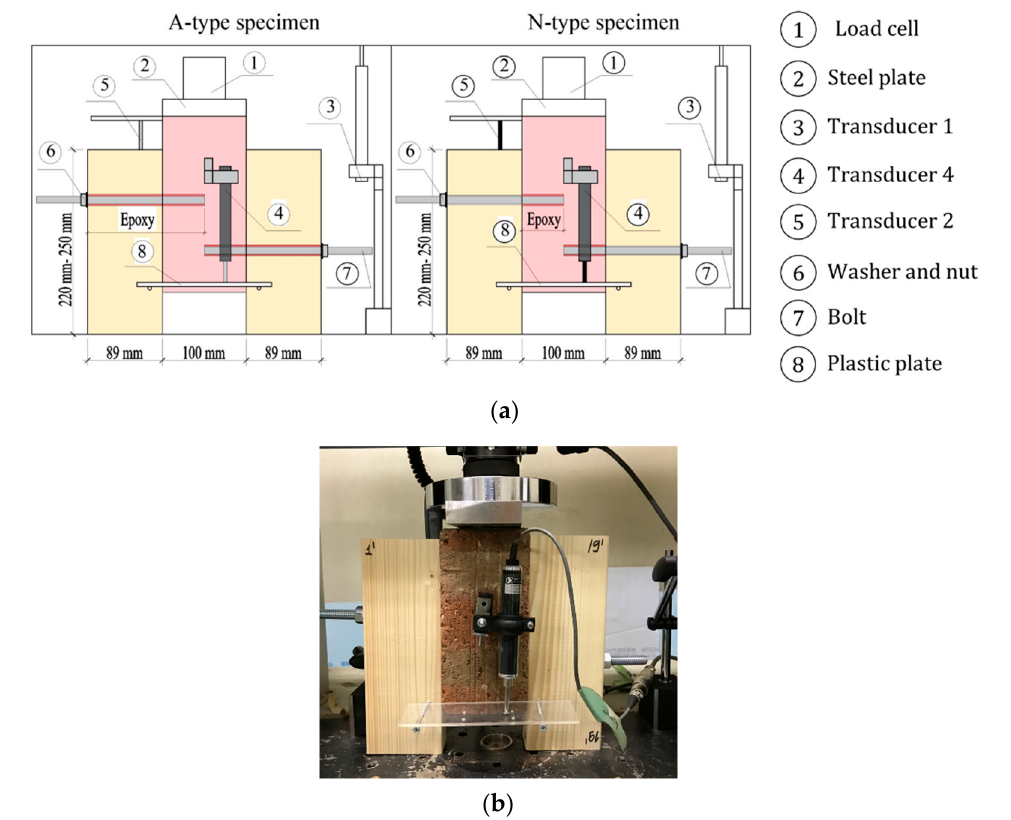
Figure 6. Specimen of shear test ( a ) schematic setup; ( b ) scene of the test setup.